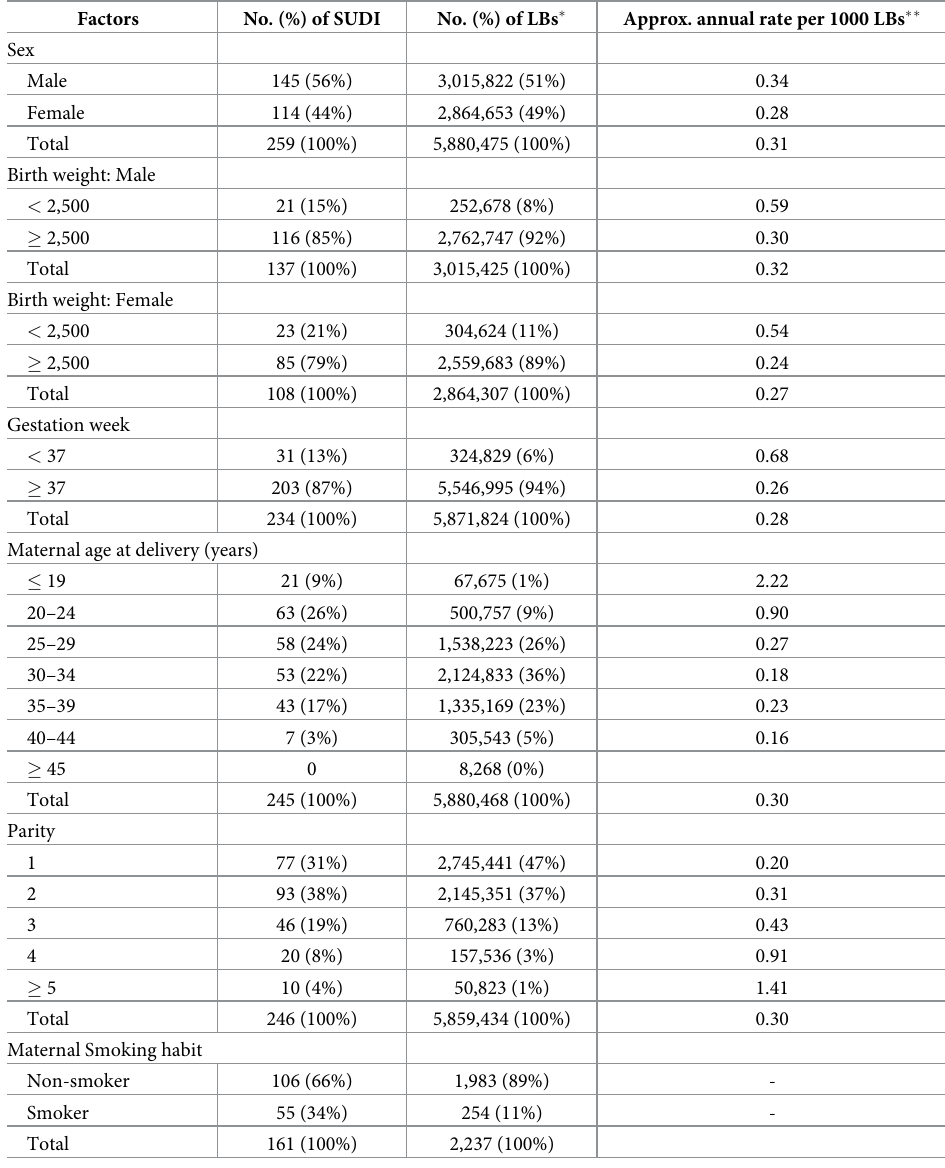
Table 1. Number of SUDI subjects and